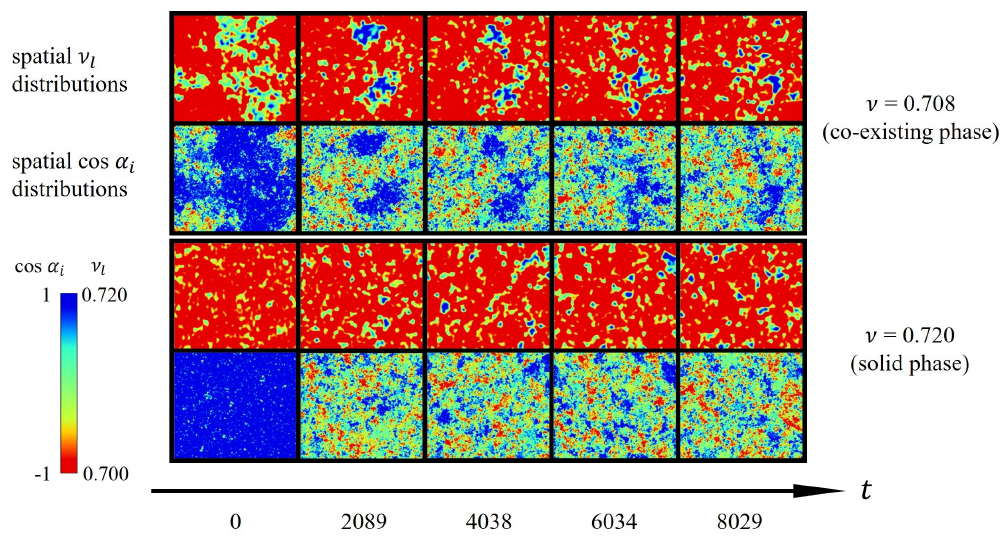
Figure 3. The spatial distributions’ evolving process for both the local packing fraction and the orientational order parameter at ν = 0 . 708 (upper two lines) and ν = 0 . 720 (lower two lines) are shown, respectively. At ν = 0 . 720, the entire system is a homogeneous (crystal) phase like the liquid phase initially where the location of disorder (melting) patches seems to emerge homogeneously. On the contrary, at ν = 0 . 708, a partial domain of the crystallized phase exists at first and persists for a long time. These inhomogeneities due to the co-existing of two phases might cause a dominant contribution to the relaxation time of physical properties.